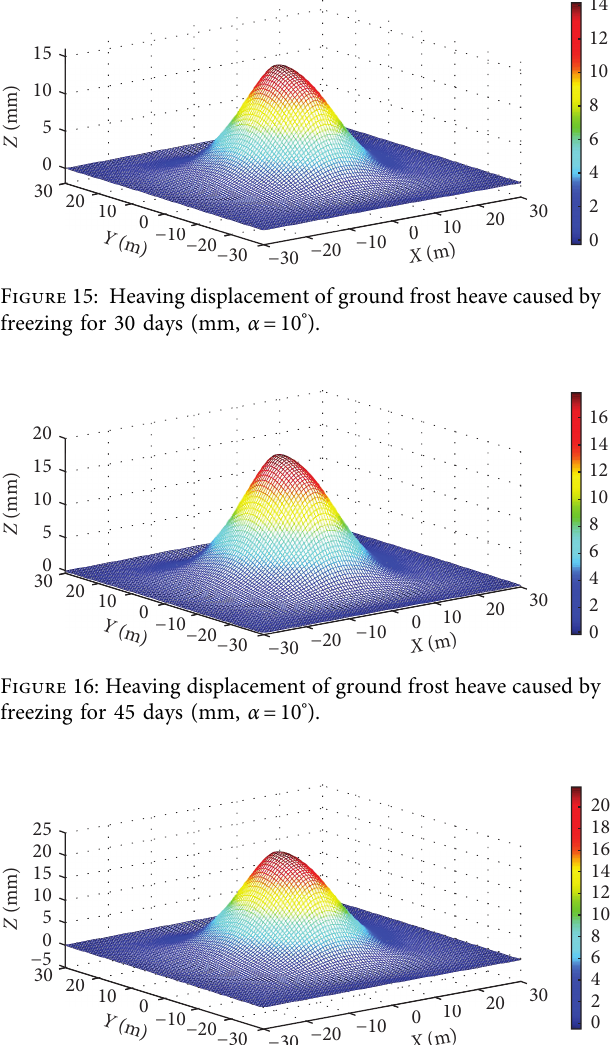
Figure 17: Heaving displacement of ground frost heave caused by freezing for 60 days (mm, α � 10 ° ).